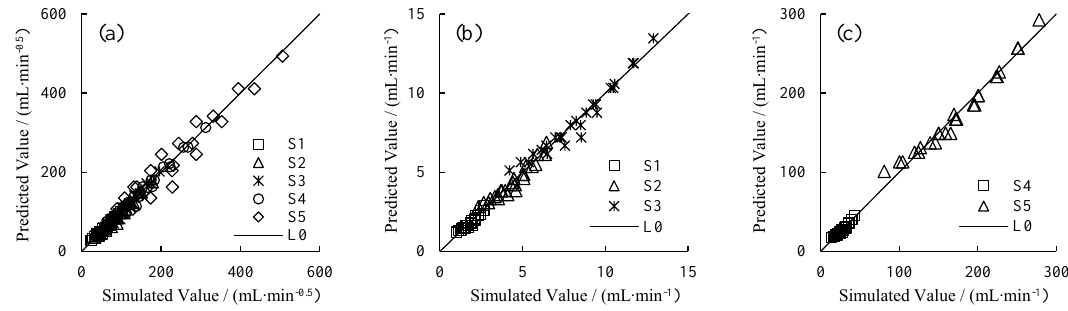
Figure 6. Comparison of simulated and estimated S and A. ( a ) soil water sorptivity; ( b , c ) steady infiltration rate. S1= clay loam; S2= silt loam; S3= loam; S4= sandy loam; S5= sand; and L0= 1:1 line.